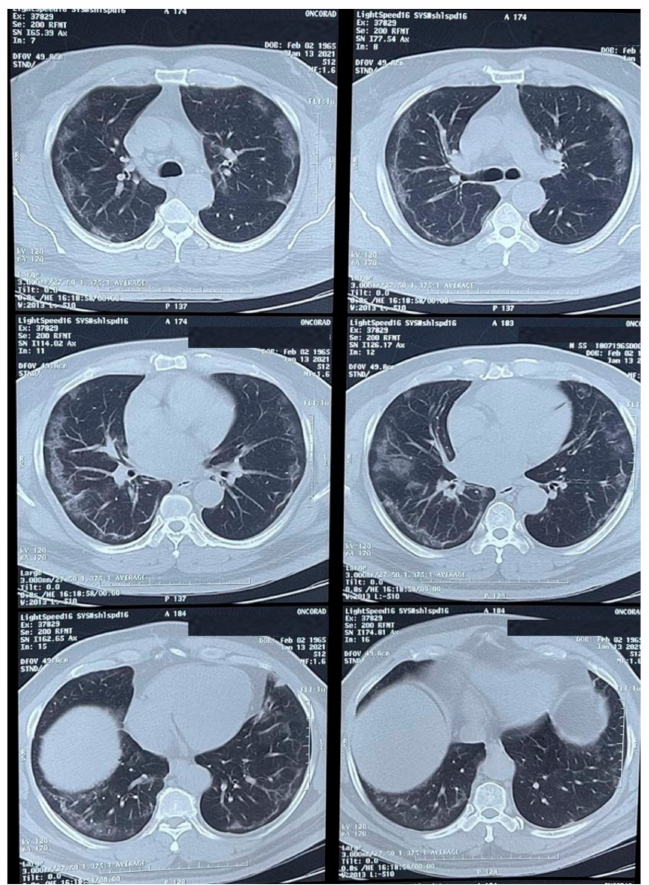
Figure 1. CT-scan of the thorax showing peripheral ground-glass opacities with a partial occupation and